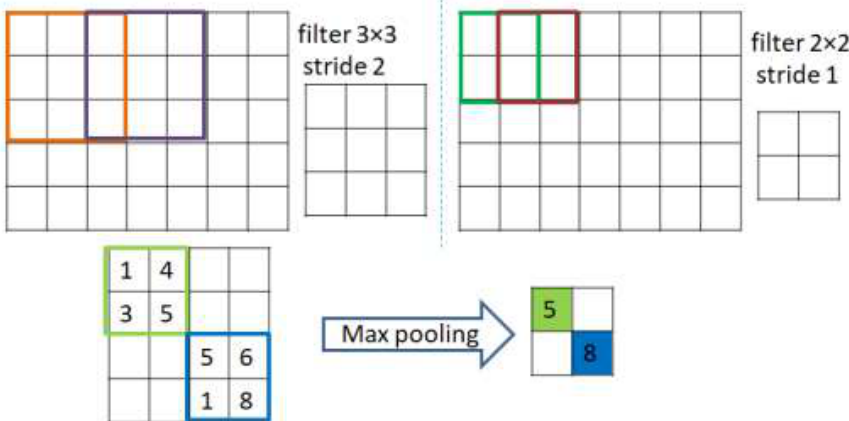
Figure 3. Presentation of convolution filters or kernels with different stride length and max pooling padding.